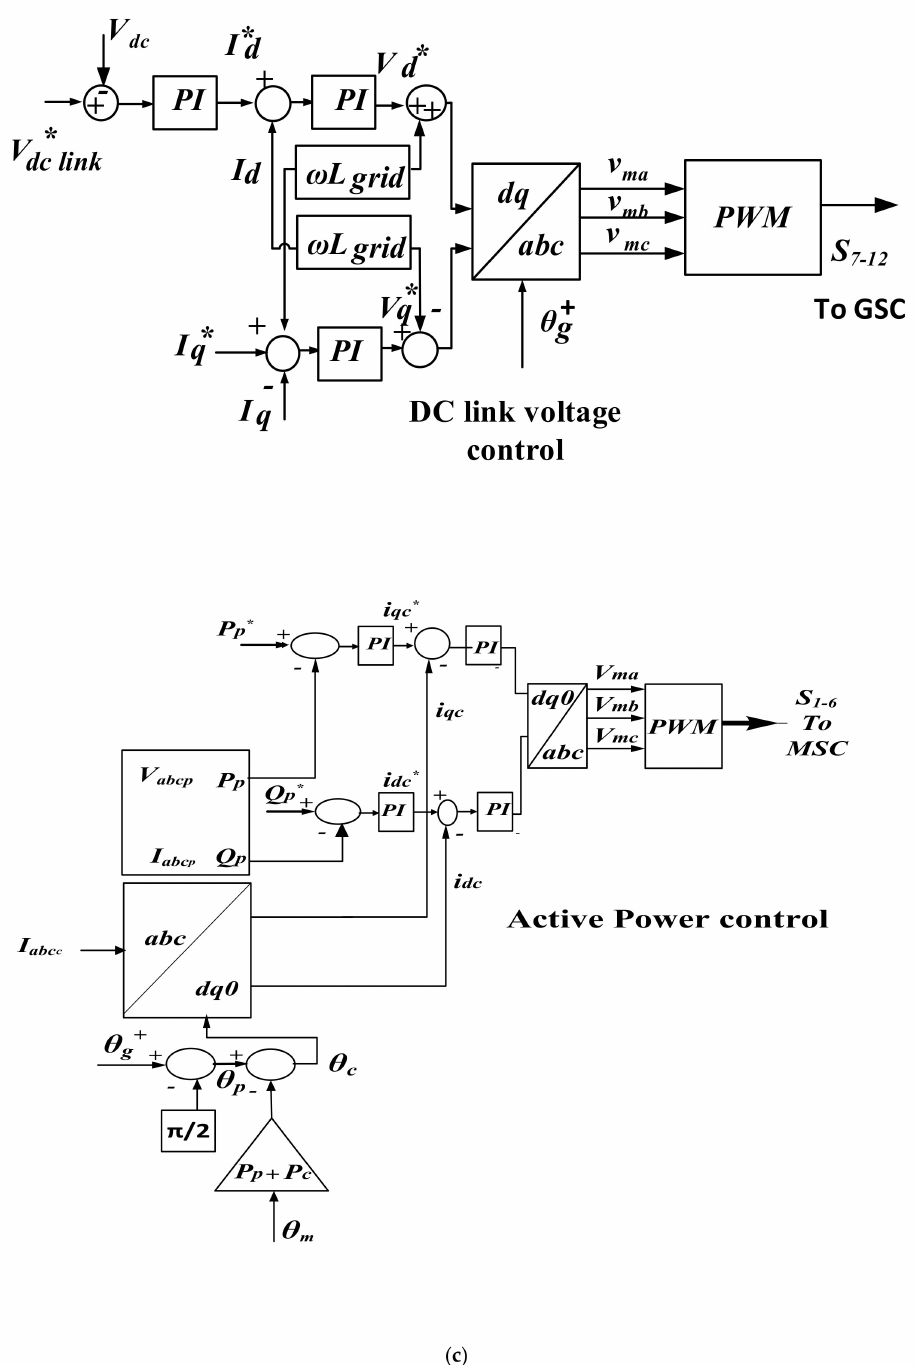
Figure 13. Experimental setup: ( a ) test rig photography, ( b ) system hardware configuration and ( c ) control block